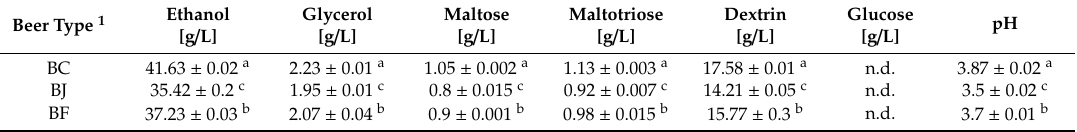
Table 1. Concentration of carbohydrates, glycerol, ethanol and pH value in tested